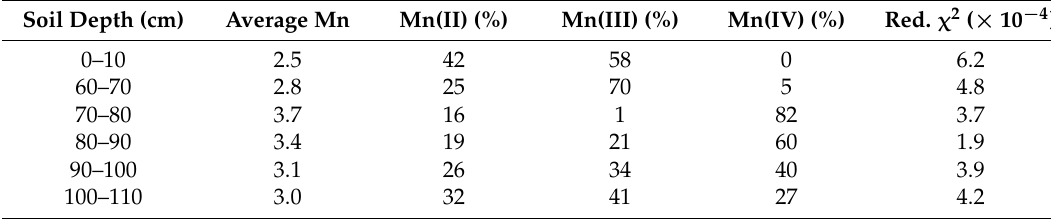
Table 3. Average Mn oxidation state determined by linear combination